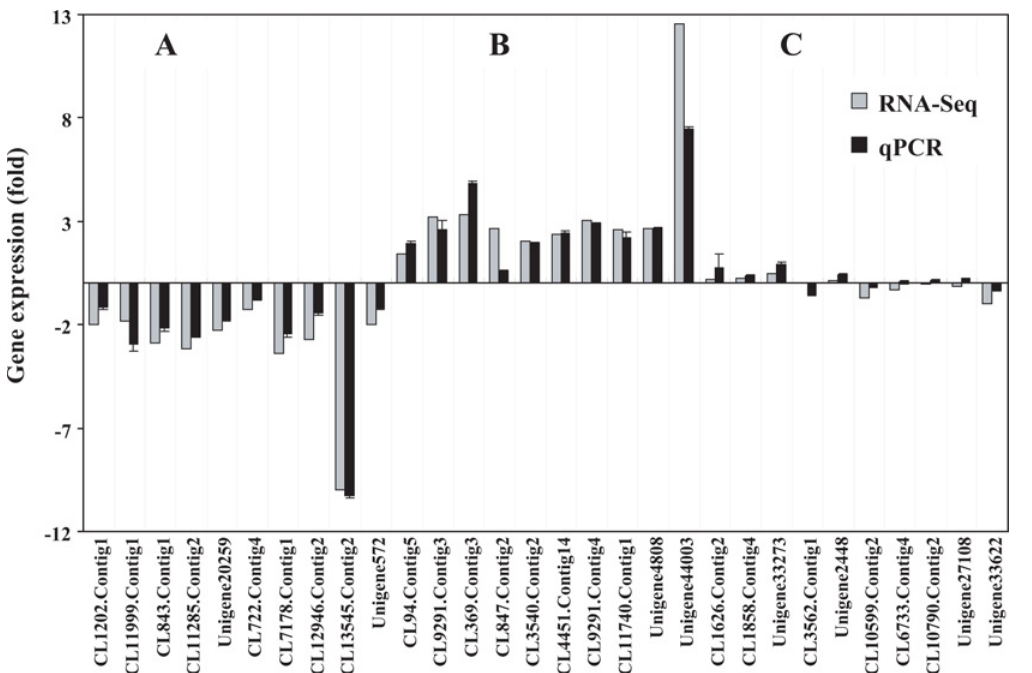
Fig 7. qPCR validation of the gene expression patterns. A total of 30 genes, including (A) 10 downregulated, (B) 10 upregulated, and (C) 10 unigenes with no difference in expression and with an absolute value of log 2 Ratio < 1, were selected, and the expression levels were confirmed using qPCR. The gray bars represent the changes in transcript abundance determined by the FPKM method. The black bars represent the relative expression levels estimated using qPCR and the 2 - ΔΔ CT method. The error bars indicate the standard deviation (n =